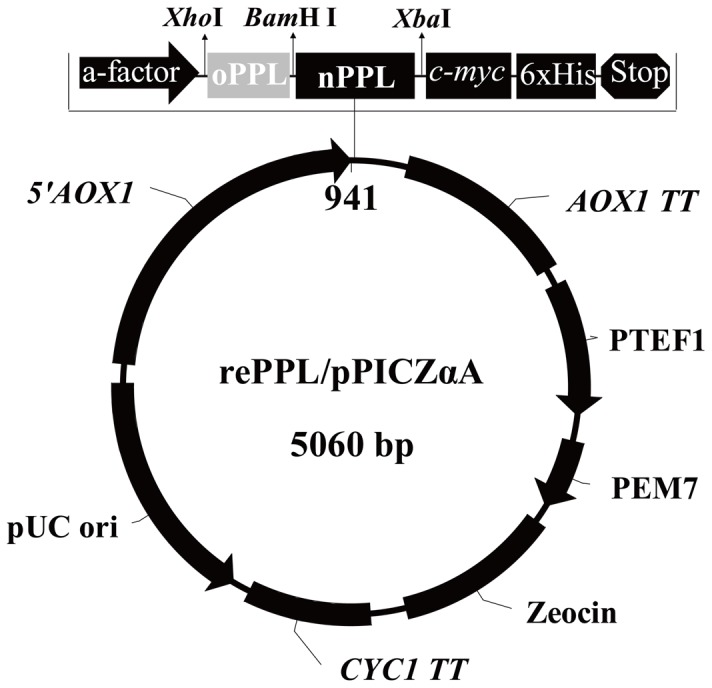
Schematic representation of expression vector opPPL/pPICZαA with 5′AOX1 promoter, fusion partner c-myc epitope, and 6×His tag.